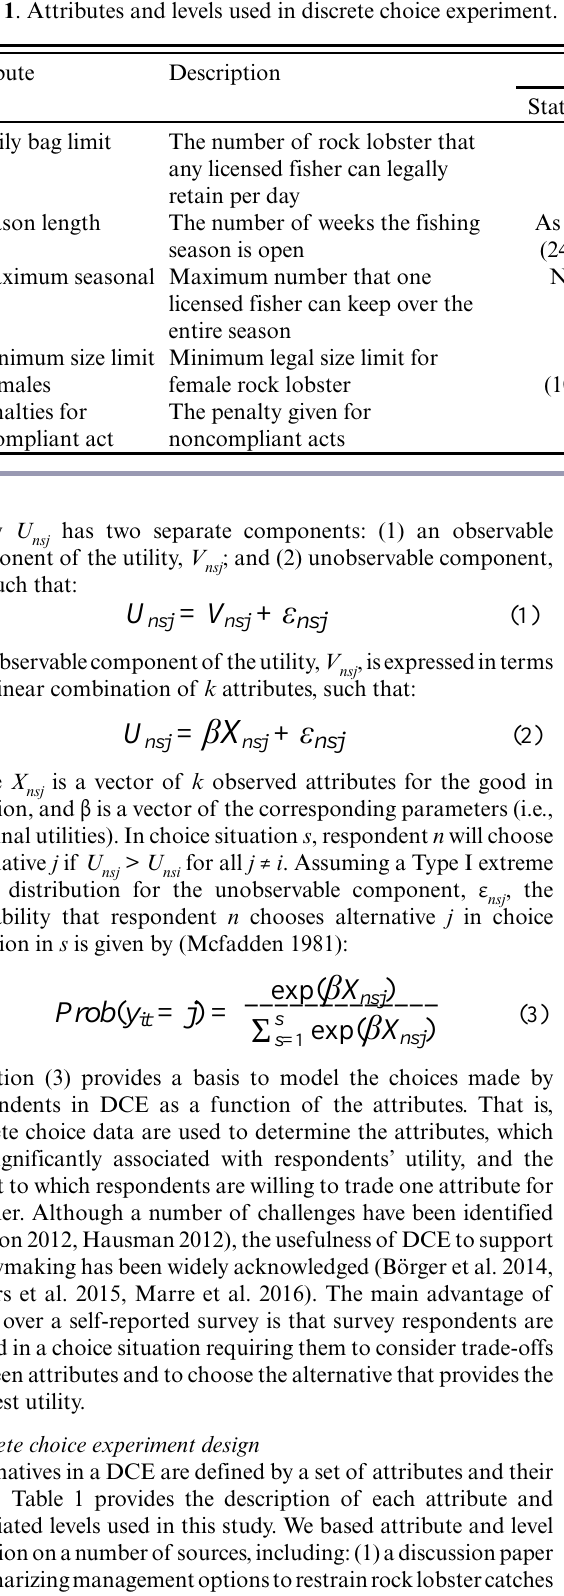
Table 1 . Attributes and levels used in discrete choice